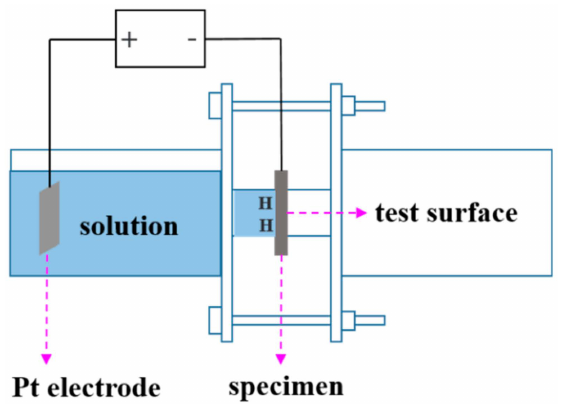
Figure 1. Diagram of single-sided electrolytic hydrogen device in Scanning Kelvin Probe Force Microscope (SKPFM).